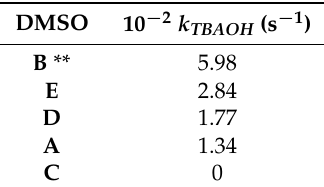
Table 2. Rate constants to characterize VI or V ( A – E ) formation (1 × 10 − 4 mol · dm − 3 ) in the